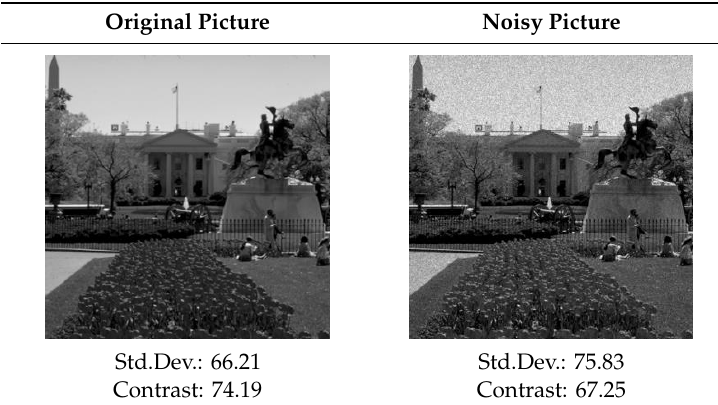
Table 1. Original and artificially noised “1600.png” image (the v variance parameter for multiplicative noise is set to 0.04).